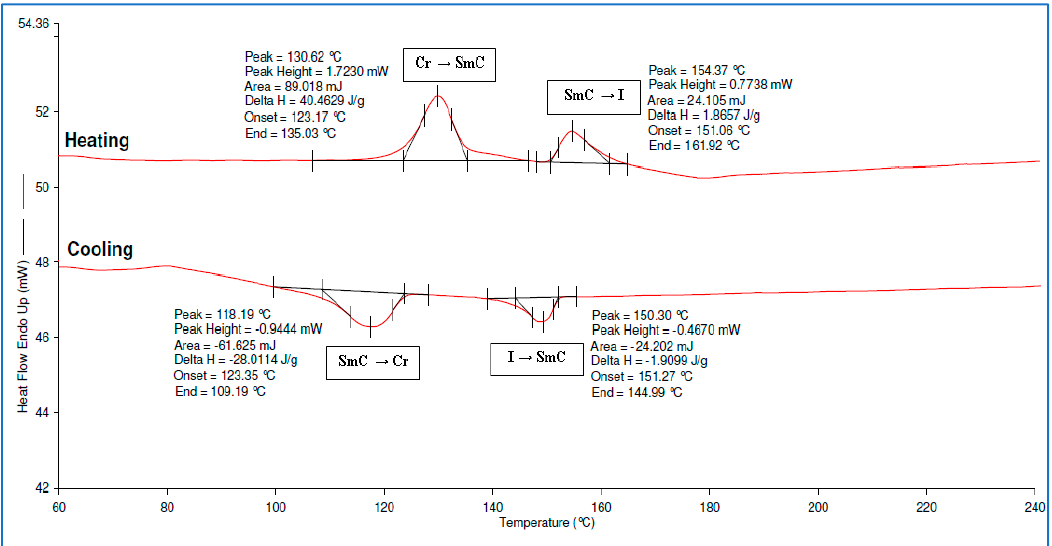
Figure 15. DSC thermogram of compound 6d .